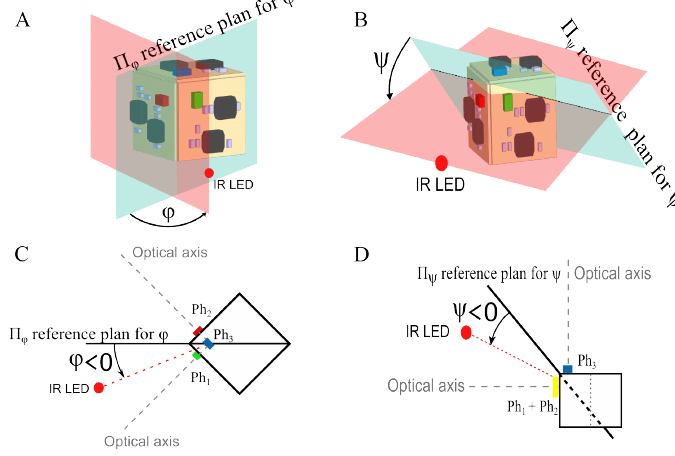
Π ; ( B ) front view, which gives an illustration of the elevation angle ψ and the reference ϕ plane Π ; ( C ) top view with the reference plane Π , which is the plane through the IR LED ψ ϕ and the optical axes of the photosensor P h and the photosensor P h ; ( D ) side view with 1 2 the reference plane Π , which is the plane through the IR LED and the optical axes of the ψ + P h virtual photosensor ( P h ) and the photoreceptor P h 1 2 3